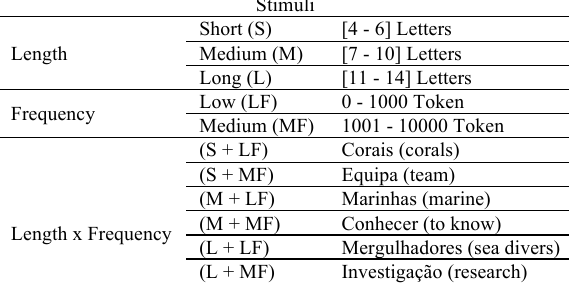
Table 3 – Word classification according to their frequency and